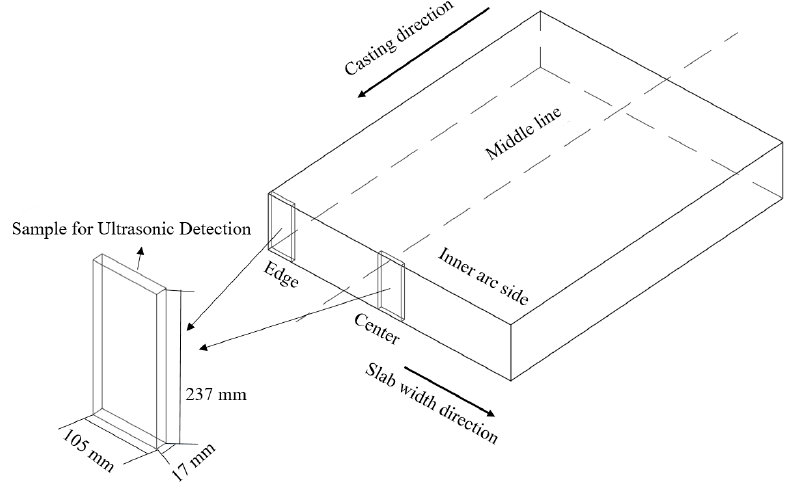
Figure 1. Schematic illustration during the sampling process.